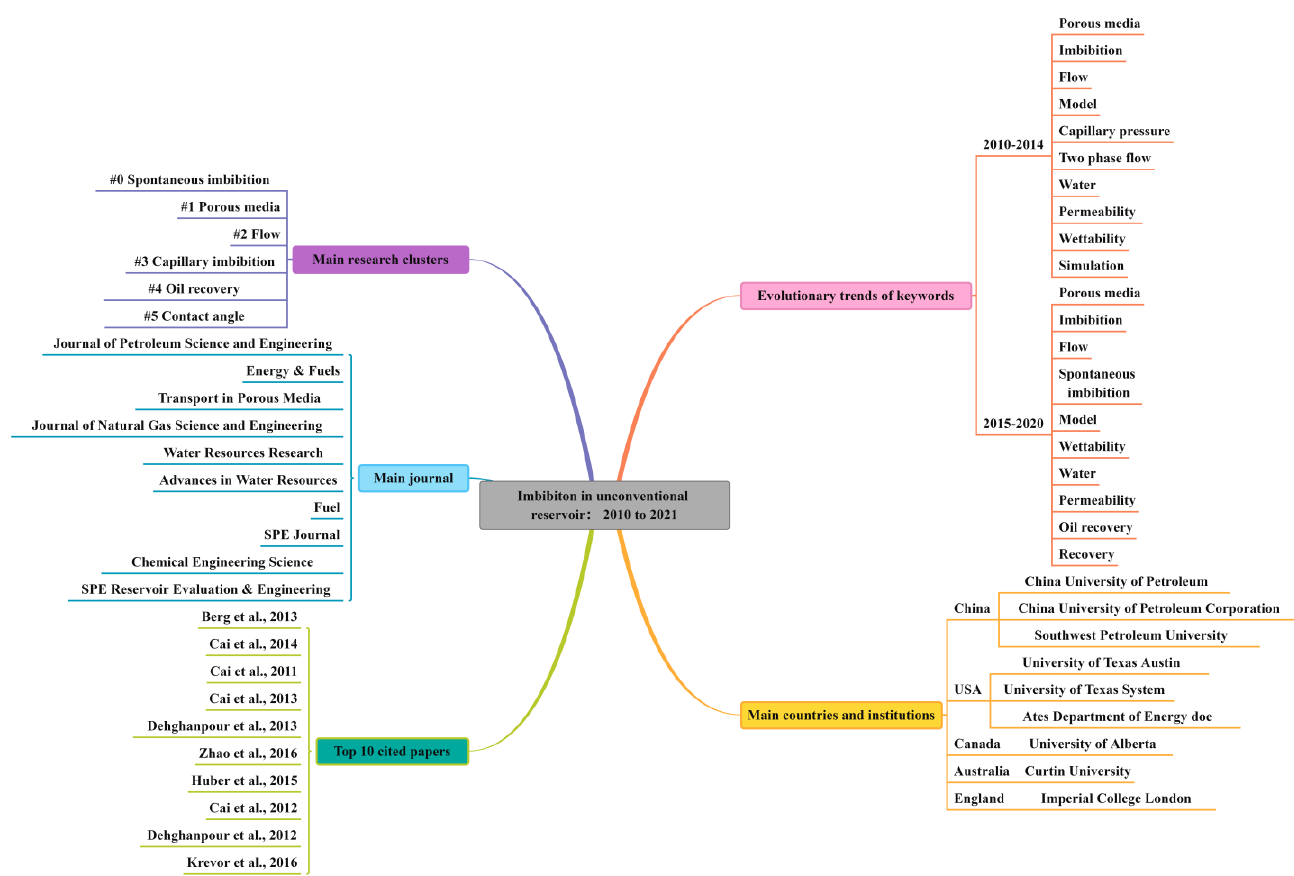
Figure 14. Comprehensive knowledge map of imbibition research in unconventional reservoirs: 2010 – 2021.